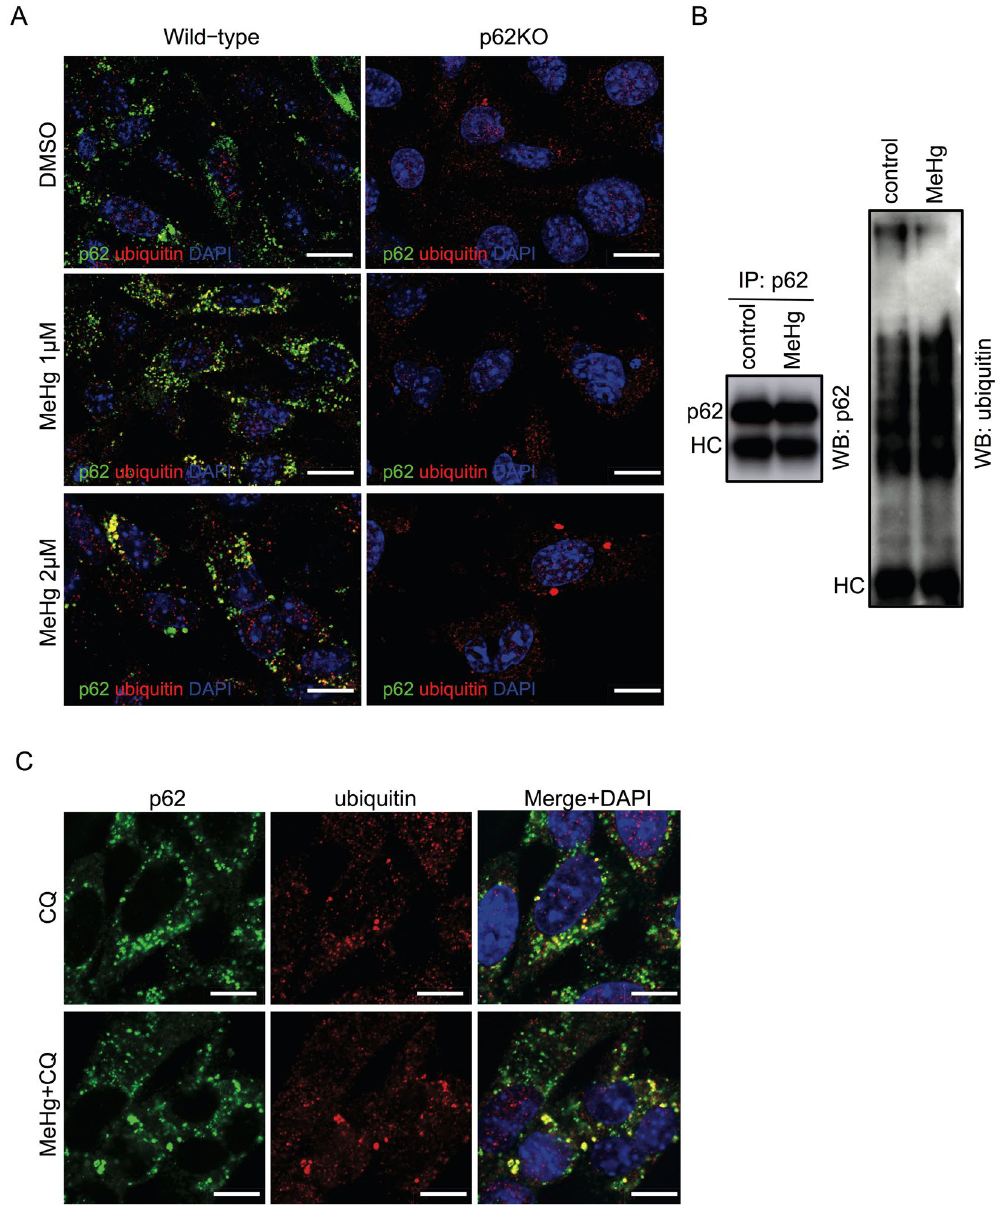
Figure 5. Methylmercury (MeHg) induces ubiquitinated proteins and co-localizes with p62. ( A ) Confocal immunofluorescence images of wild-type and p62 knockout (KO) mouse embryonic fibroblasts (MEFs) stained for p62 (green) and ubiquitinated (red) proteins. Scale bars: 20 µ m. ( B ) Wild-type MEFs were lysed with Triton X-100 buffer and 1 mg of protein was immunoprecipitated with a p62 antibody. The interaction was determined by immunoblot analyses for p62 and ubiquitin. ( C ) Confocal immunofluorescence images of wild-type MEFs stained for p62 and ubiquitin. Cells were treated with 20 µ M chloroquine (CQ) for 6 h or with 1 µ M MeHg for 18 h and 20 µ M CQ for 6 h. Scale bars: 20 µ